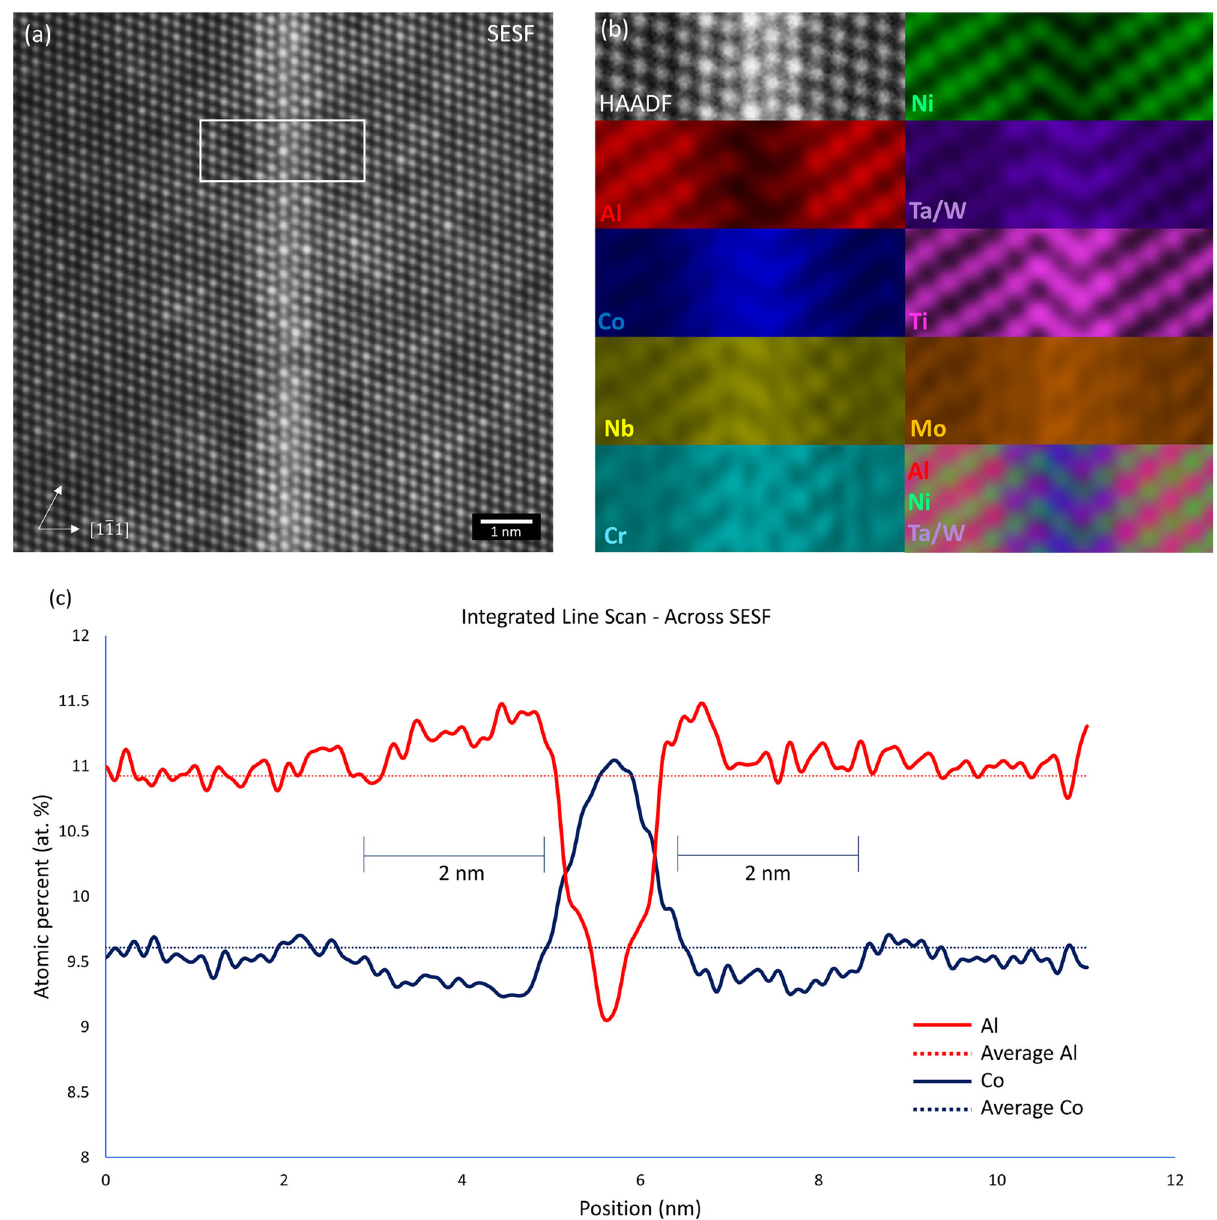
Fig. 4 Atomic resolution characterization of a SESF in TSNA-1. a HAADF STEM image of an SESF in TSNA-1 and ( b ) atomic resolution chemical maps of the SESF. The lowest right map is a composite of the Ni, Al, and Ta/W maps revealing η phase formation. c Integrated line scans of Al and Co across an SESF in TSNA-1 revealing an increase in Al content adjacent to the fault and a decrease in Co compared to the average values of the two